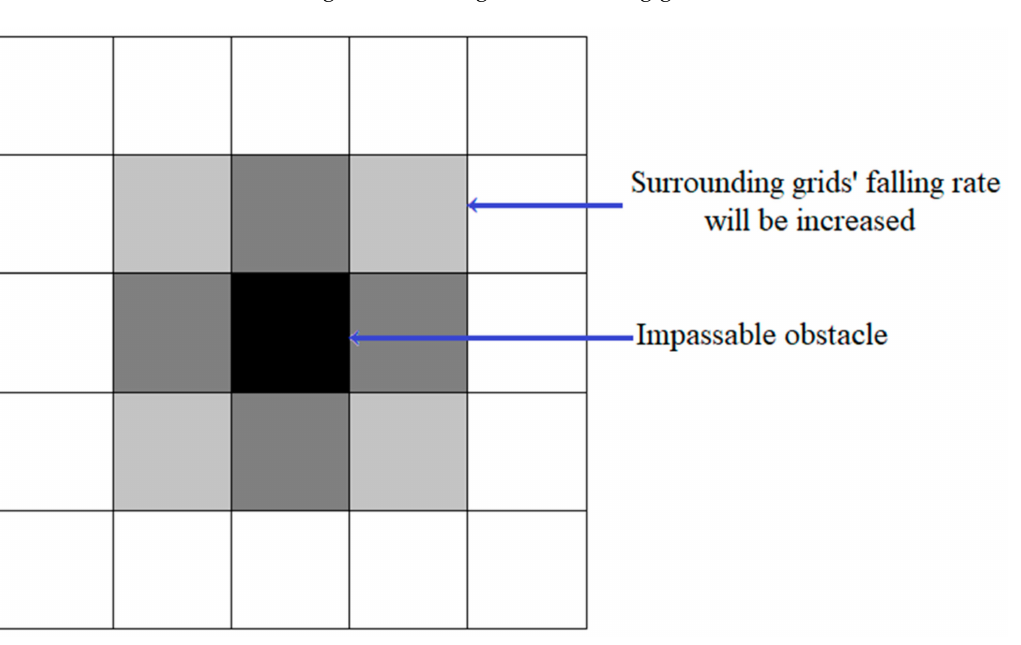
Figure 5. The diffusion of artificial potential